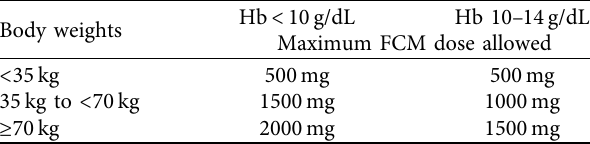
Table 1: Cumulative FCM dose for iron repletion. Body